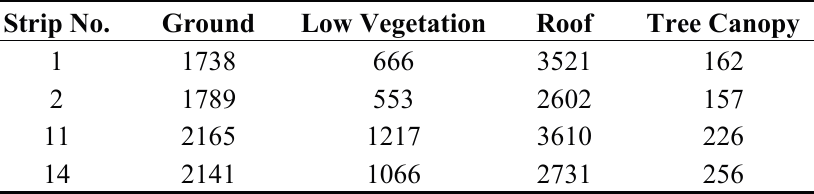
Table 2. Number of samples over the four strips.